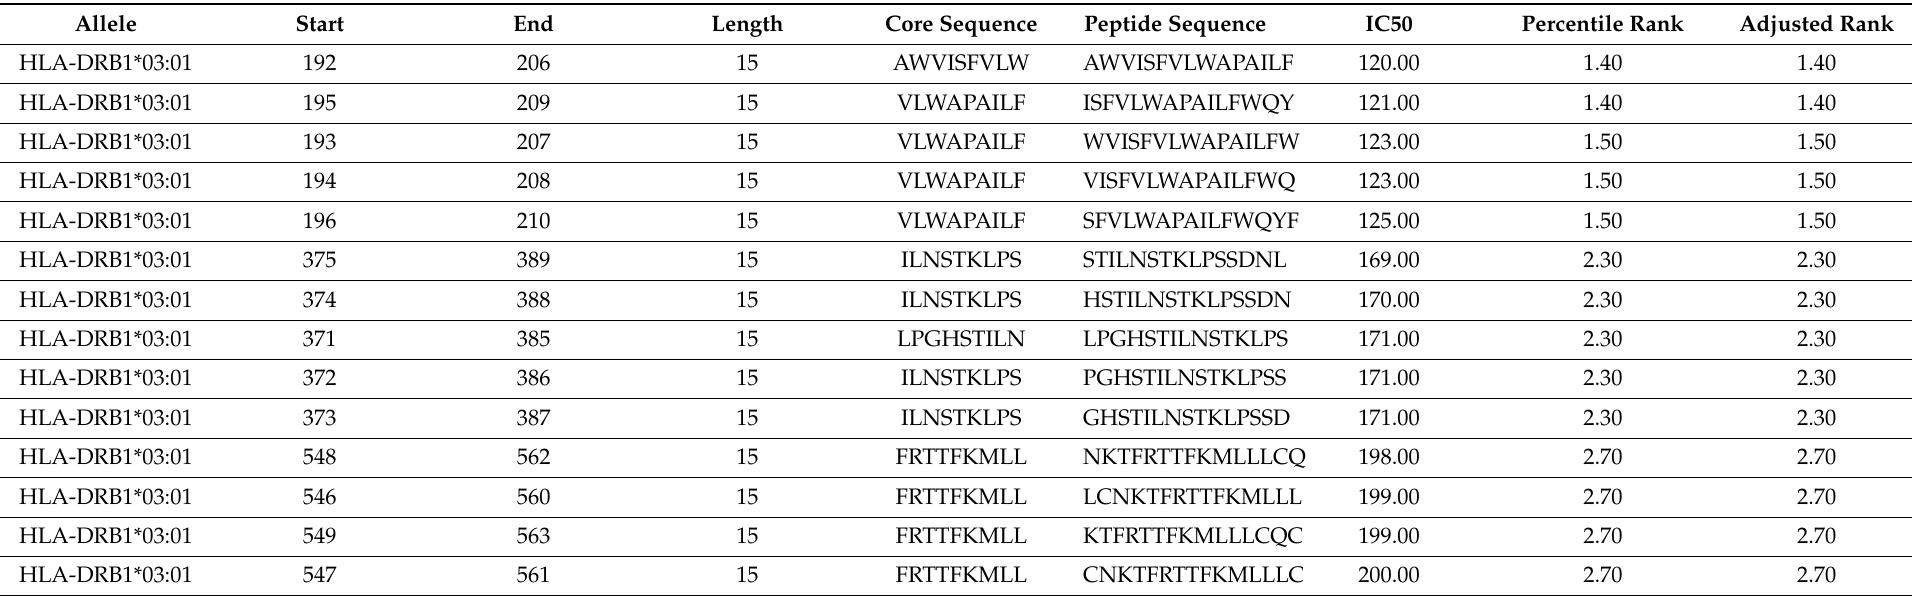
Table 7. HLA-DR3 allele with predicted peptides of human